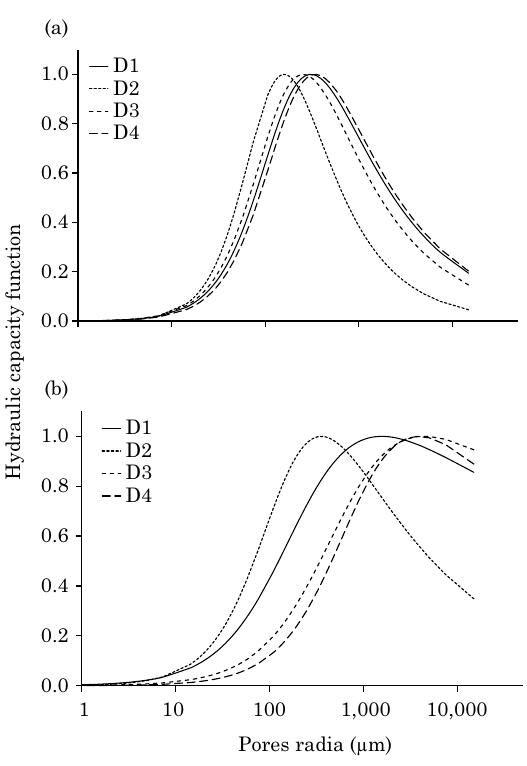
Figure 4. Normalized contrasting pore size distributions (PSDs) obtained by using the hydraulic capacity function (C w ) under the continuous arable cropping system (a) and natural bush fallow system (b) for depths D1 (0-5 cm), D2 (5-10 cm), D3 (10-15 cm), and D4 (15-20